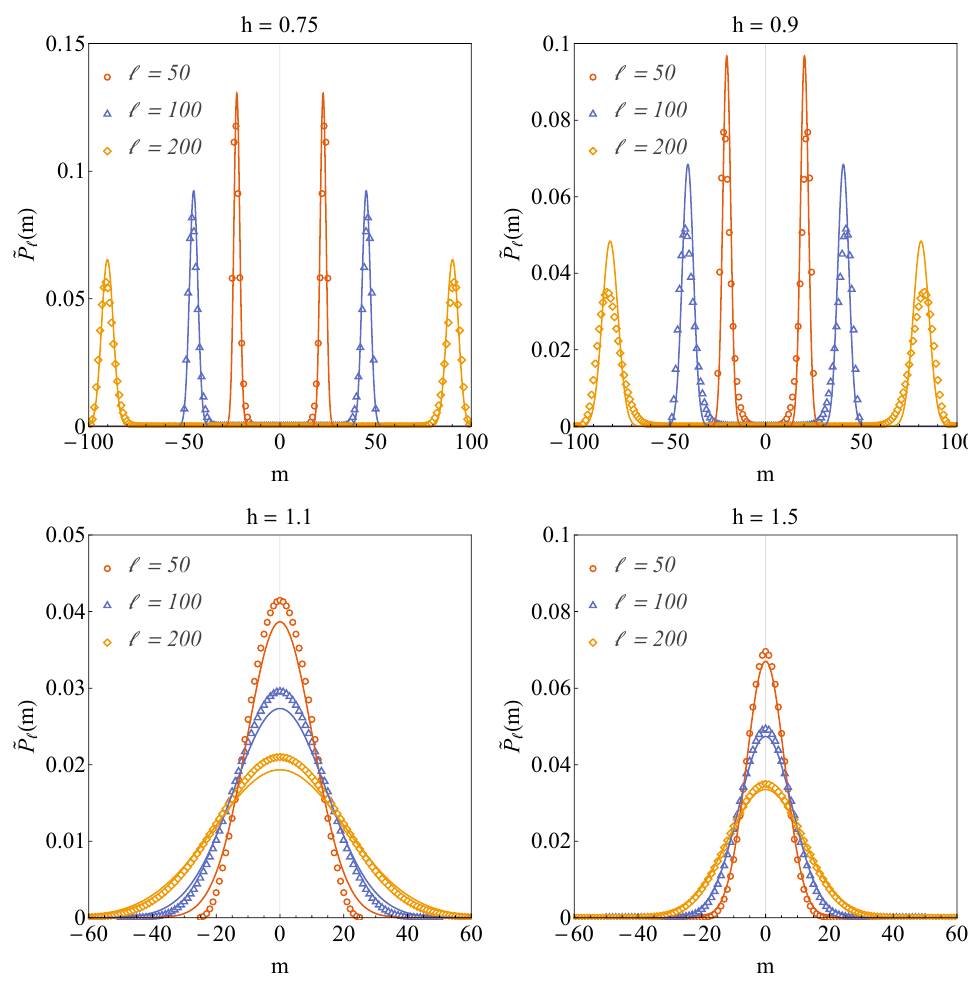
Figure 7: Asymptotic behaviour of ground-state PDF in the ferromagnetic region (top row) and in the paramagnetic region (bottom row). Symbols are the exact iTEBD results, full lines are the asymptotic approximation (71) or (75) depending on the